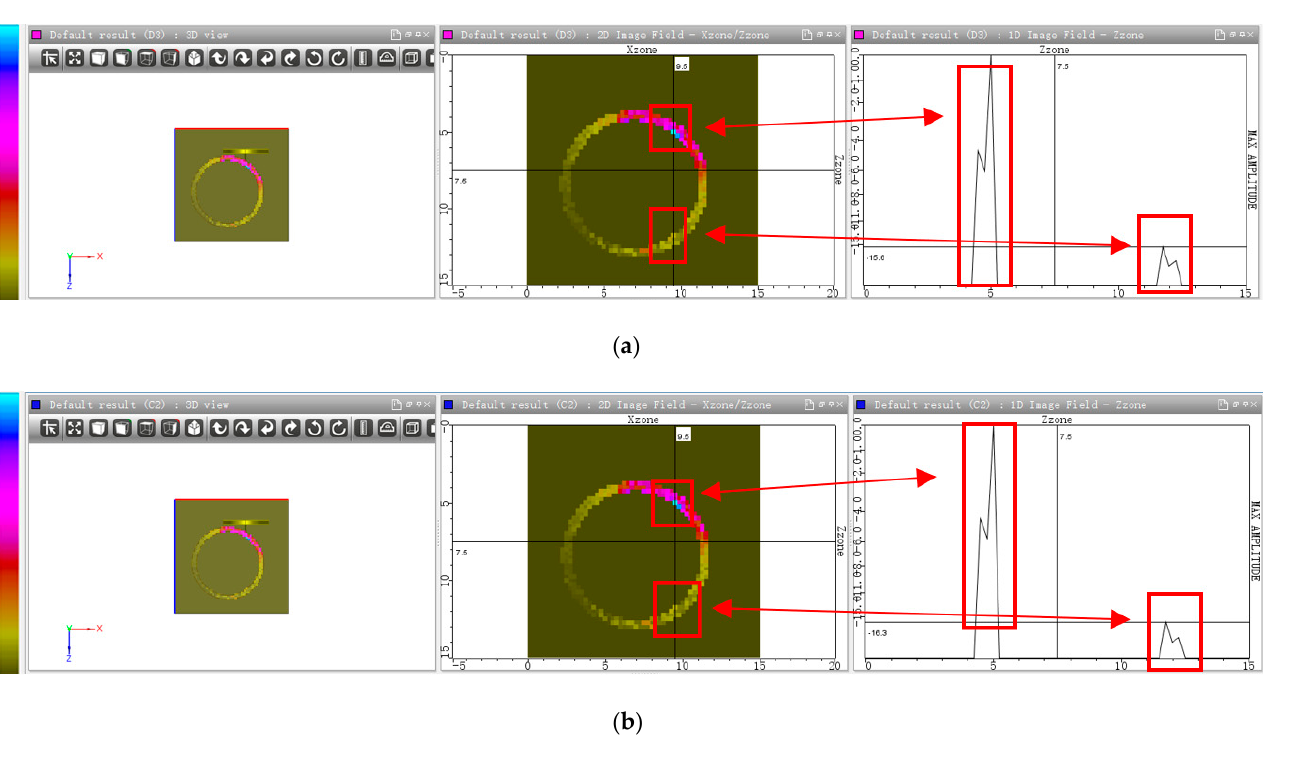
Figure 8. ( a ) The sound field with normal fuel rod; ( b ) the sound field with failed fuel rod.